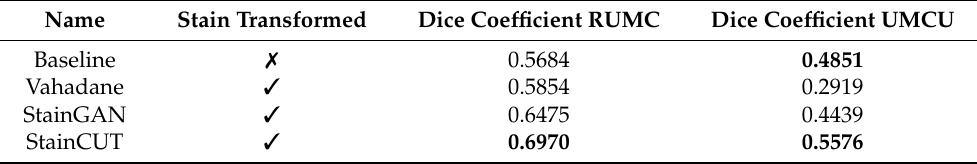
Table 6. The mean values of the dice coefficient score for the segmentation of both datasets, when the stain normalization is applied during evaluation (Setting 2). The dice coefficient is calculated by comparing the generated masks and the ground truth masks for each WSI. The corresponding statistical tests can be found in Tables A10 and A11 in Appendix C. Bold highlights the best results that are not significantly